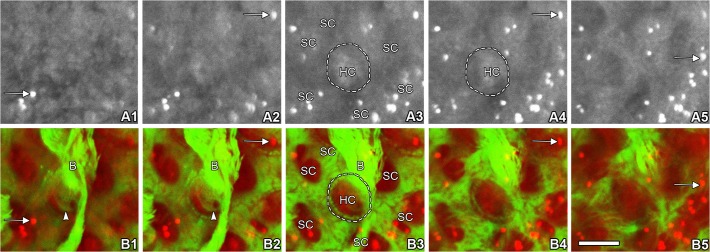
Distribution of GTTR differs in hair cells and supporting cells of the LSC.
An xy focal series of images through the z axis of the LSC from the apical surface into the base of crista were shown. The sensory epithelia of LSC crista fixed 2 hours after systemic GTTR injection (A1–5 red channel, GTTR; B1–5 merged red and green channels; red, GTTR; green, Alexa-488 conjugated phalloidin to visualize filamentous actin). Hair cells displayed only diffuse GTTR fluorescence (HC) while supporting cells (SC) exhibited both intensely fluorescent GTTR puncta (arrows) and diffuse GTTR fluorescence. In color images (B1–5), the actin-rich hair bundle (B) is distinctly localized in B1-B3, and the cuticular plate is shown in B1 and B2 (arrowheads). Characteristic phalloidin labeling is also shown at the hair cell circumference as a distinctive green “dotted” ring in B3 and B4. Scale bar in B5 = 5 μm.